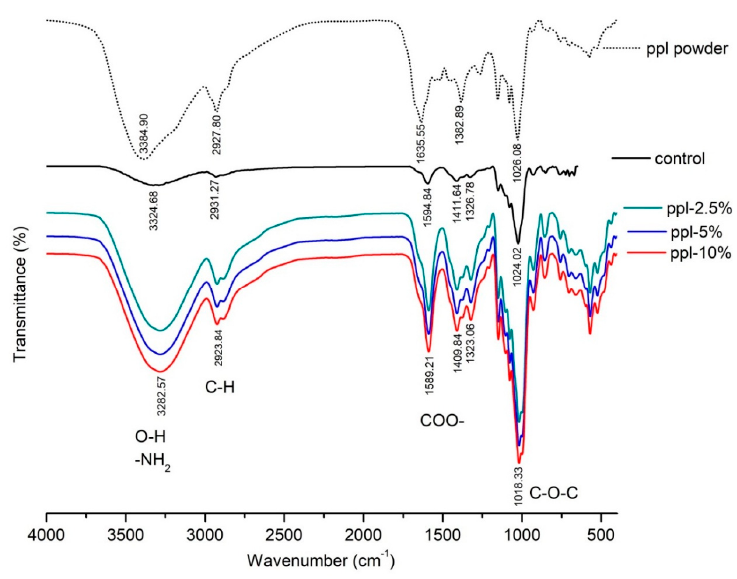
Figure 3. FTIR spectra of the ppl powder and the produced films.